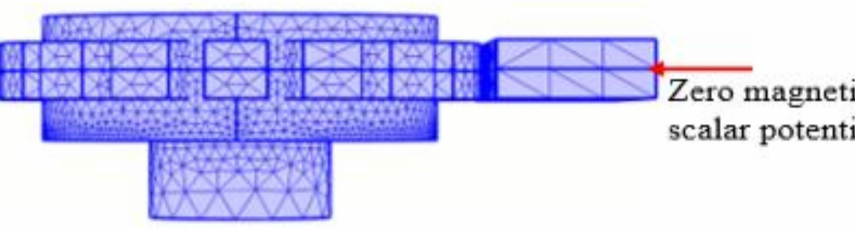
Figure 8. Mesh analysis of the TME